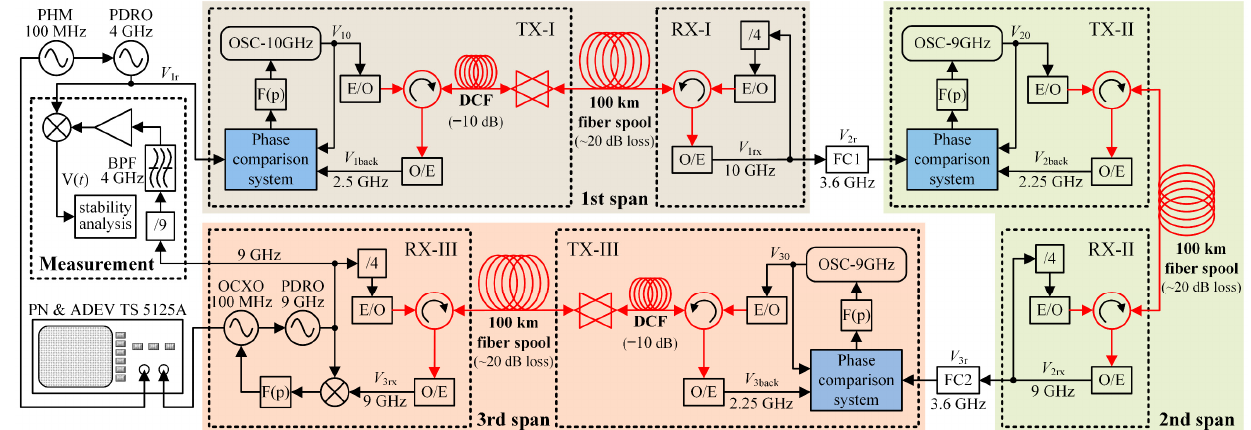
Figure 3. Schematic of the cascaded transfer system. E/O: electrical to optical; O/E: optical to electrical.